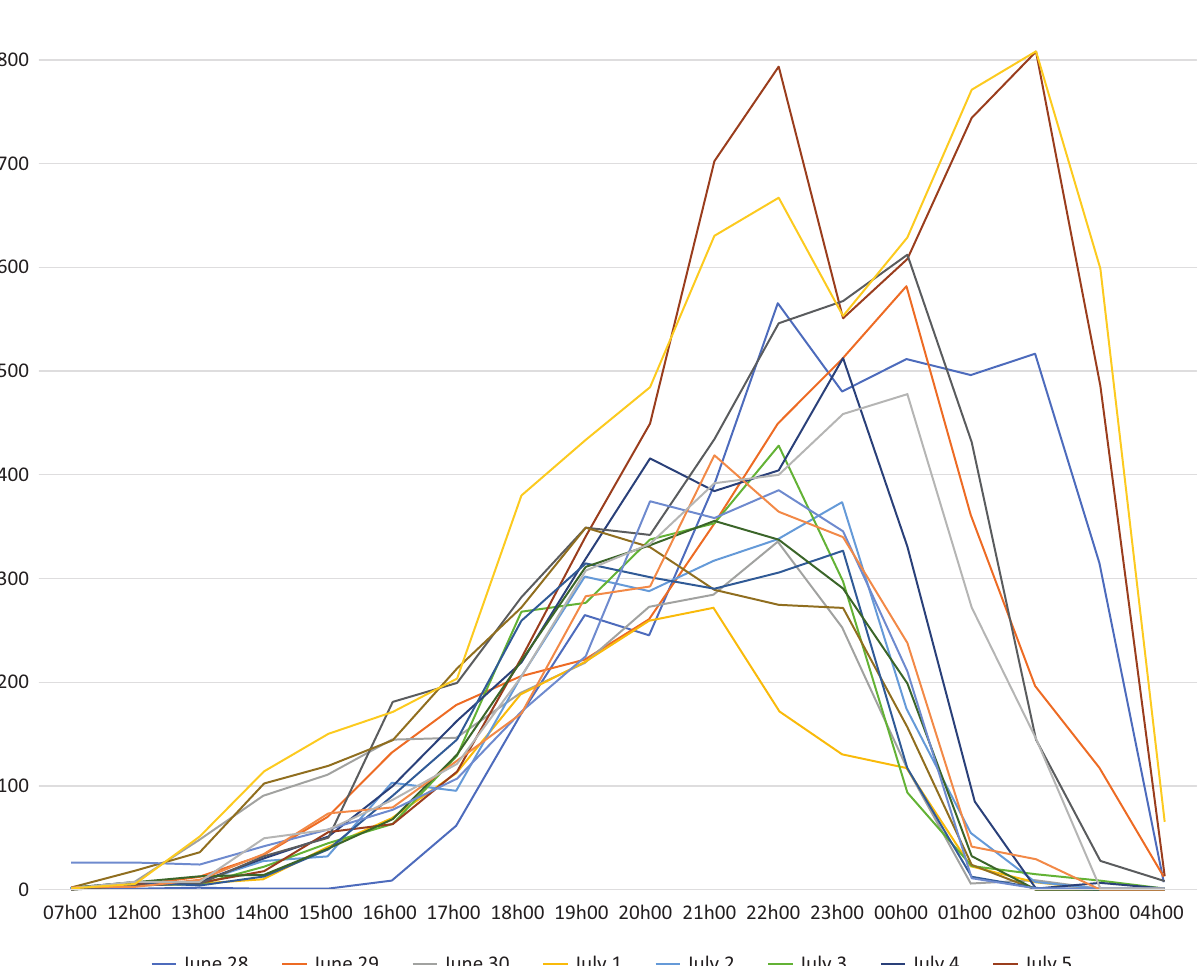
from midnight to 1:00. Also, the greatest rhythmic inten- sity in terms of transactions occurs later during the week- end. This result indicates a more progressive attendance compared to ticket